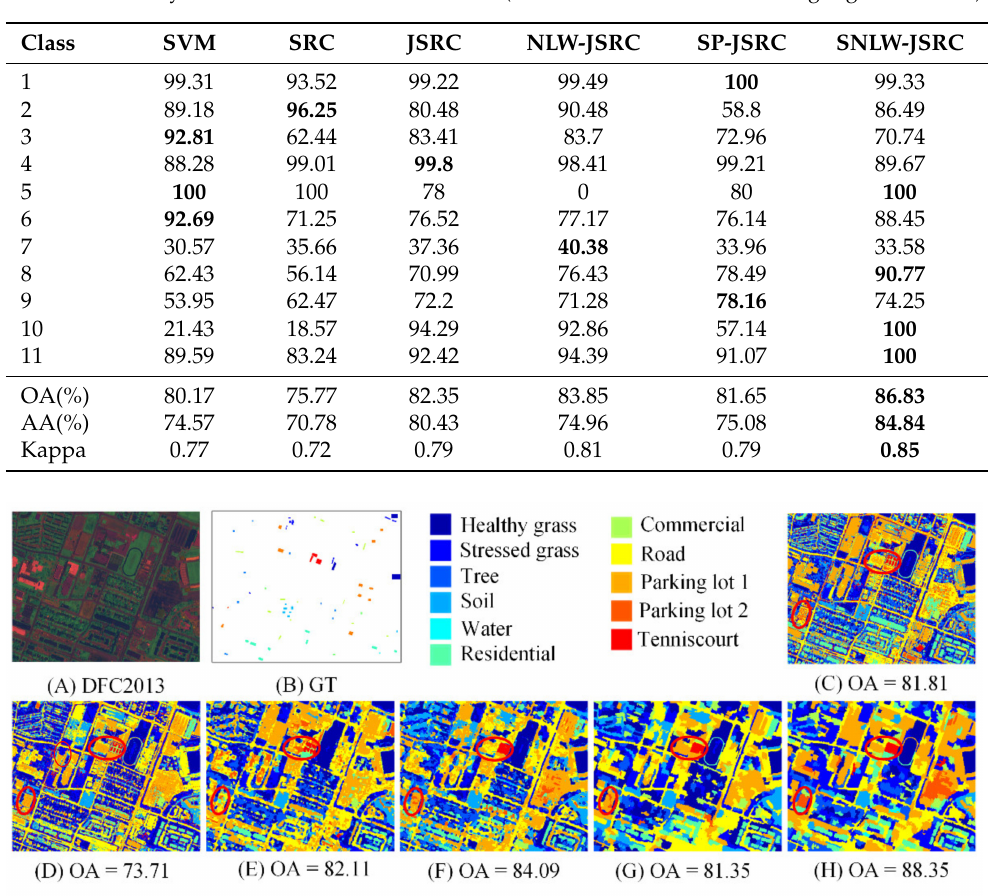
Figure 7. DFC2013 image: ( A ) composite color image and ( B ) ground truth; estimation map obtained by ( C ) SVM; ( D ) SRC; ( E ) JSRC; ( F ) NLW-JSRC; ( G ) SP-JSRC; ( H ) SNLW-JSRC.